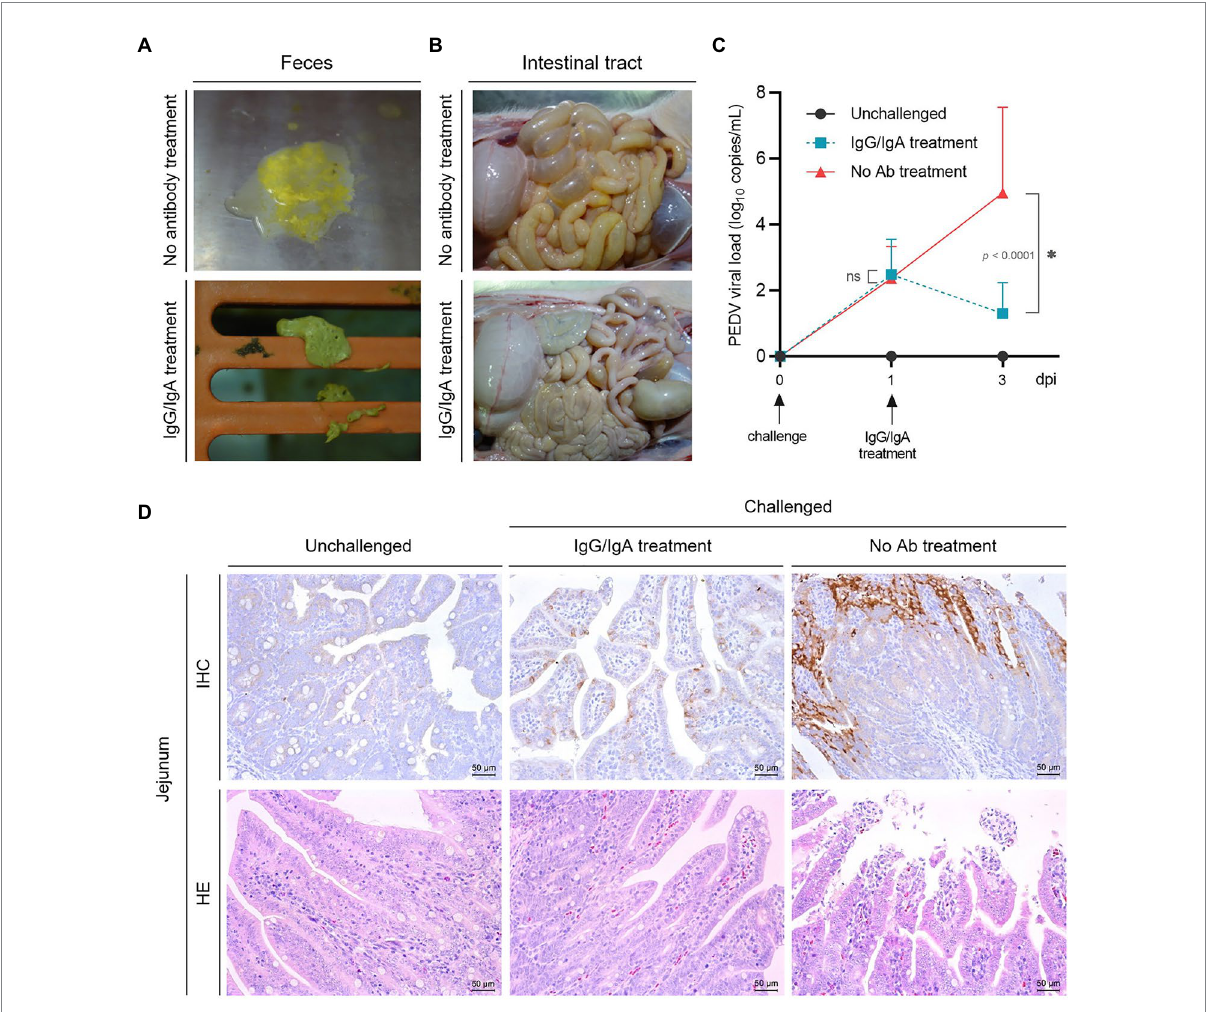
FIGURE 5 Evaluation of the therapeutic effect of chimeric IgG/IgA produced by CHO cell line. Piglets feces (A) and intestinal tract (B) in group 2 (one day after IgG/IgA treatment) and 3 (no antibody treatment). (C) The PEDV RNA copies in the feces of piglets, the error bars indicated standard deviation. Data were analyzed using two-way ANOVA by time. (D) IHC and HE assay of the piglets in group 1 (unchallenged), 2 (IgG/IgA treatment) and 3 (no antibody treatment). dpi,